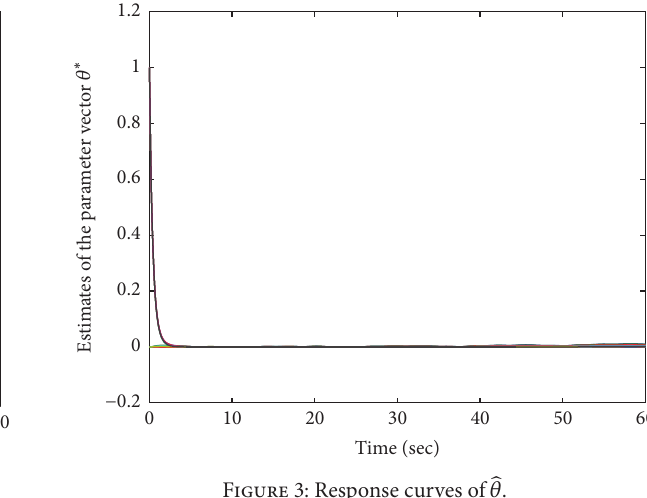
Figure 3: Response curves of